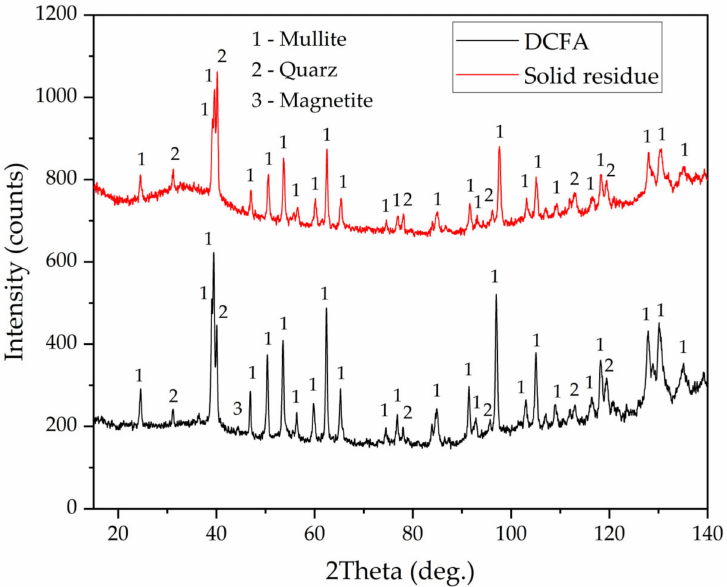
Figure 11. XRD patterns of DCFA and the solid residue obtained by the DCFA leaching at 110 ◦ C, L/S ratio = 10, and leaching duration 5 h.